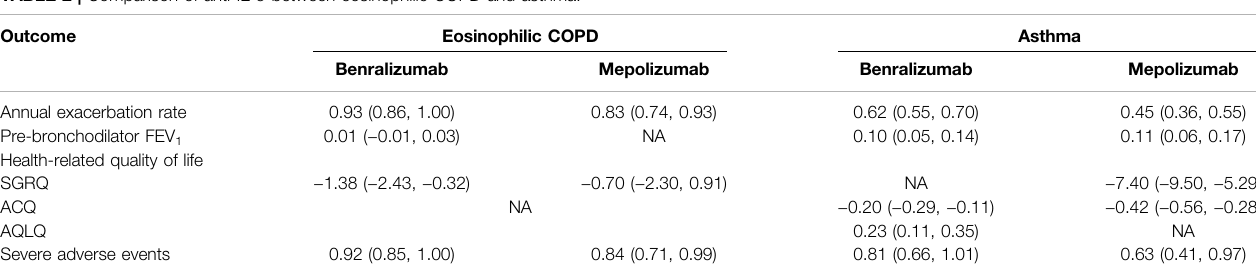
TABLE 2 | Comparison of anti-IL-5 between eosinophilic COPD and